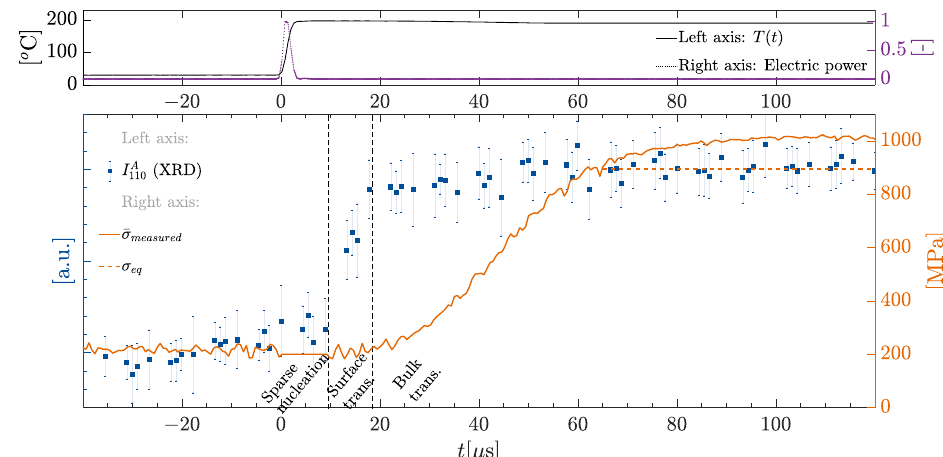
Figure 6. Typical results of experiments in the clamp-clamp configuration. ( Top ) Average wire temperature evolution in time, based on Ref. [34]. The dotted line shows the 3 µ s pulse of electric ∼ power transferred to the wire, in normalized units, the onset of the electric pulse was chosen as t = 0. ( Bottom ) The blue squares are the integrated XRD intensity I A ( t ) of the austenite 110 A peak, normalized with respect to its mean final value (i.e., mean of plateau after 20 µ s), corresponding to an estimated austenite volume fraction of 0.261 [46]. The solid curve is the mean measured tensile stress from all experiments shown in units of MPa, marked on the right vertical axis. The horizontal dashed line represents the equilibrium stress value averaged over the interval [1.4, 5] ms after the pulse (See Figure 5). The vertical dashed lines denote the different stages of the transformation. Reproduced from Dana et al. (2021) [34] with permission from